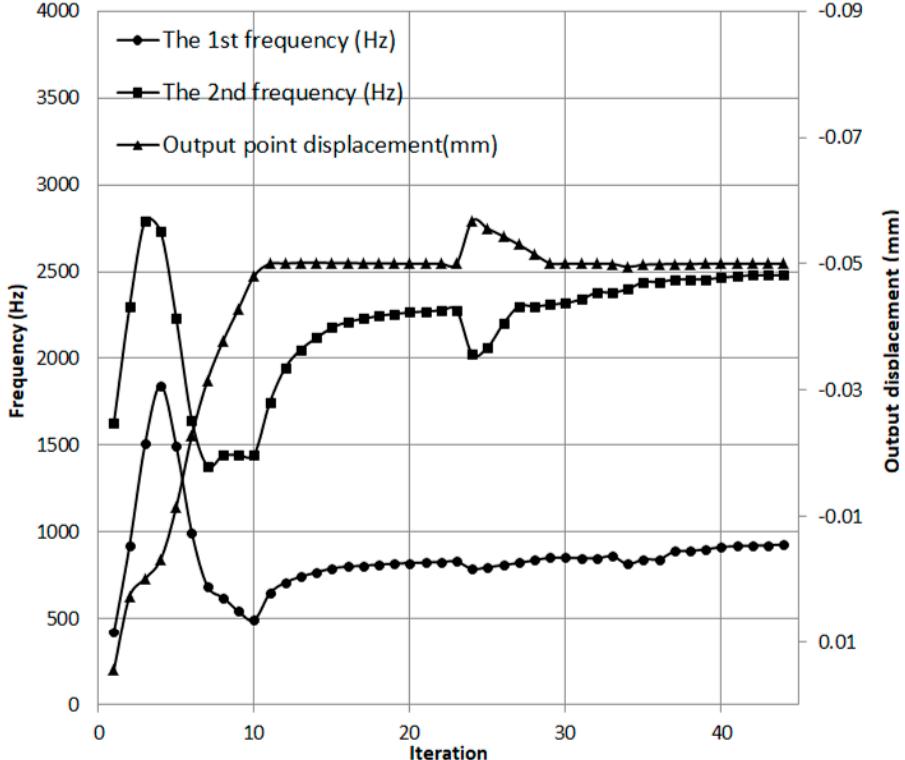
Figure 5. Convergence history of output displacement and eigen-frequency for the invent mechanism.